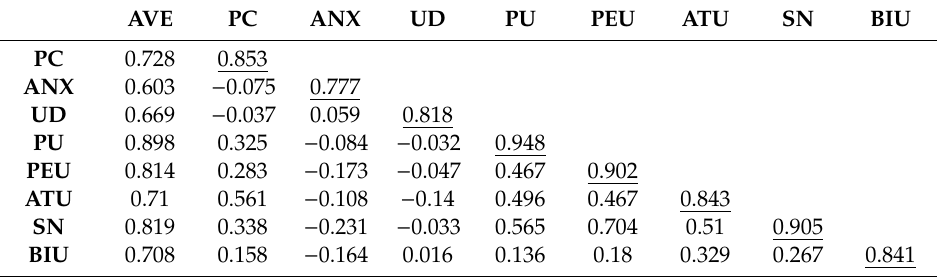
Table 11. Fornell-Larcker Criterion (for ETS).